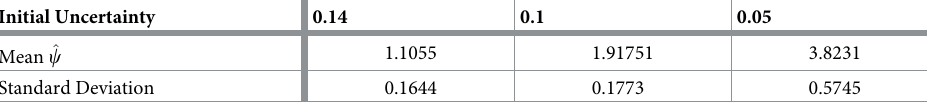
Table 3. The mean estimated opinion cluster count for each 100 simulations under different initial uncertainty.